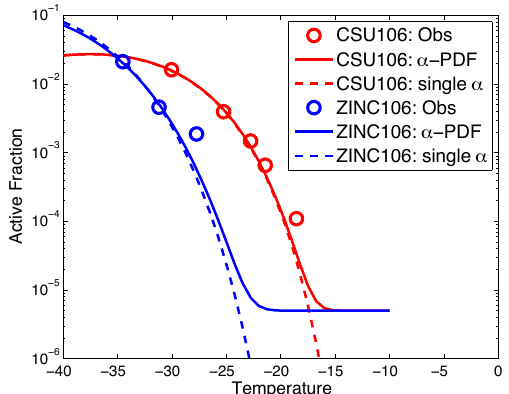
Figure 1. Active fractions determined with CSU106 and ZINC106 (DeMott et al., 2011) are presented as a function of temperature T (indicated by the different color circles). The different lines rep- resent the single- α model and the α -PDF model results fitting the experimentally determined active fractions (parameters in the two models are given in Table